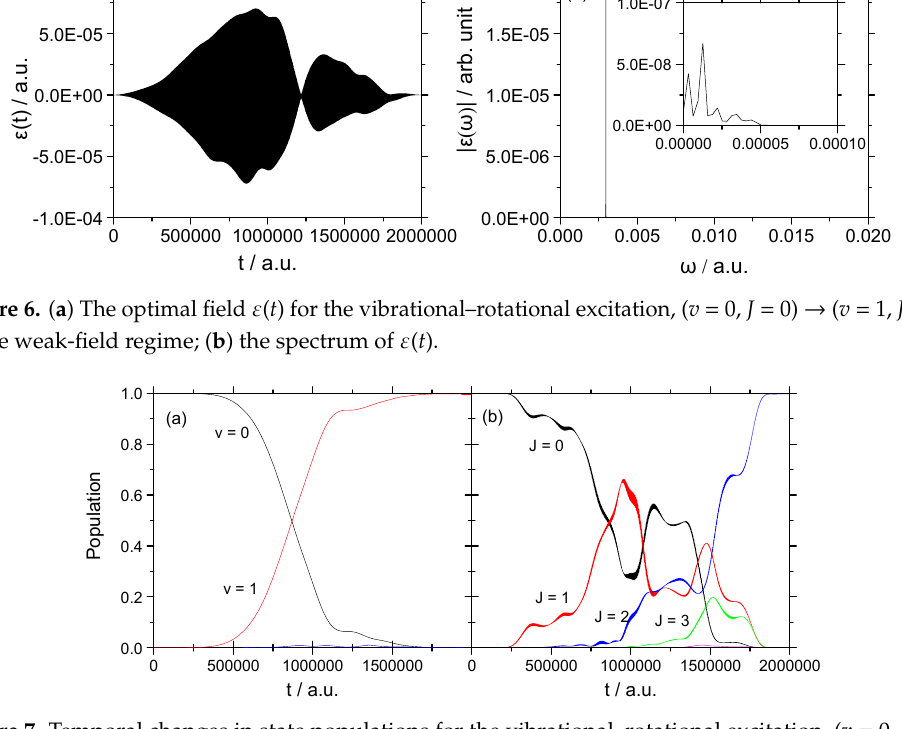
Figure 7. Temporal changes in state populations for the vibrational–rotational excitation, ( v = 0, J = 0) → ( v = 1, J = 2), in the weak-field regime: ( a ) vibrational states; ( b ) rotational states.